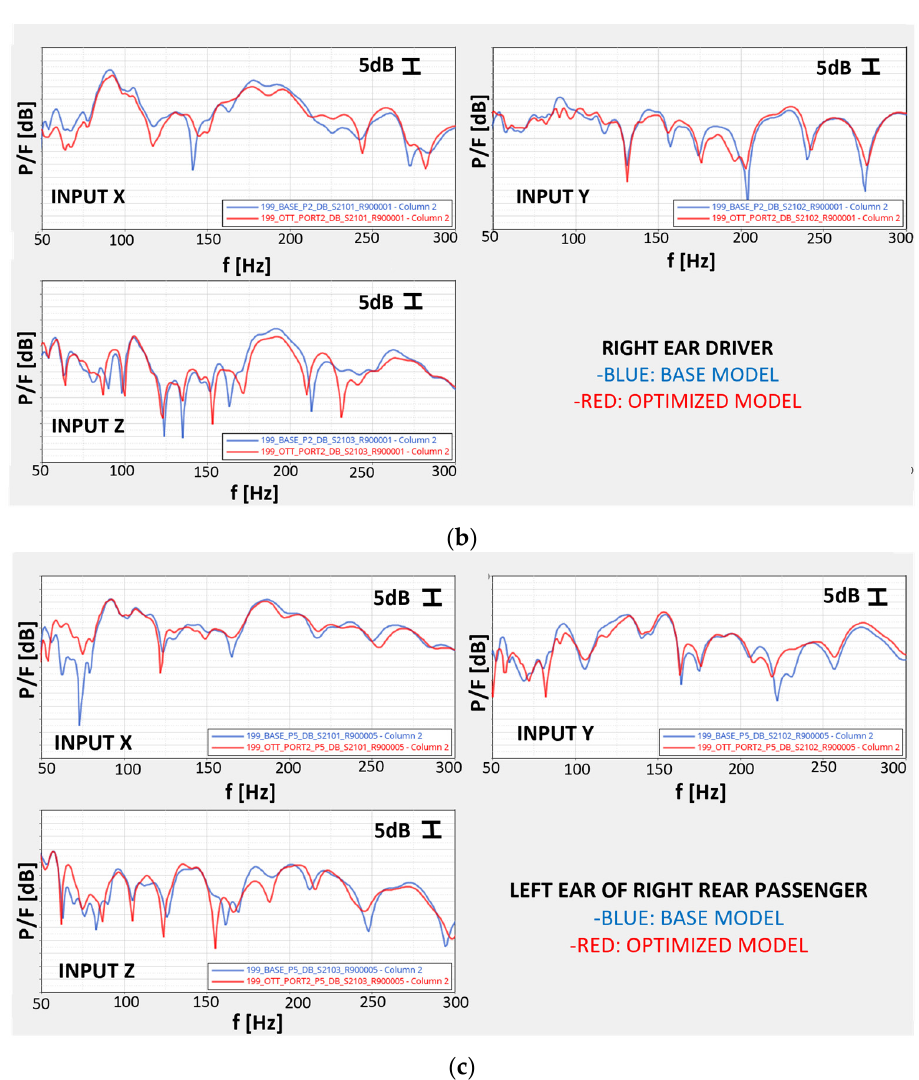
Figure 33. Vibrational excitation at left front dome ( a ) and related transfer-functions ( b , c